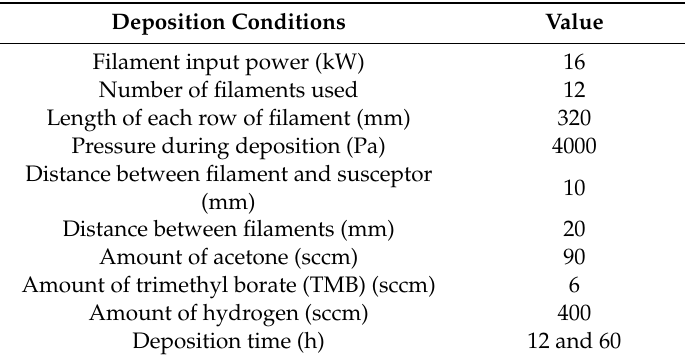
Table 1. Deposition conditions used in the